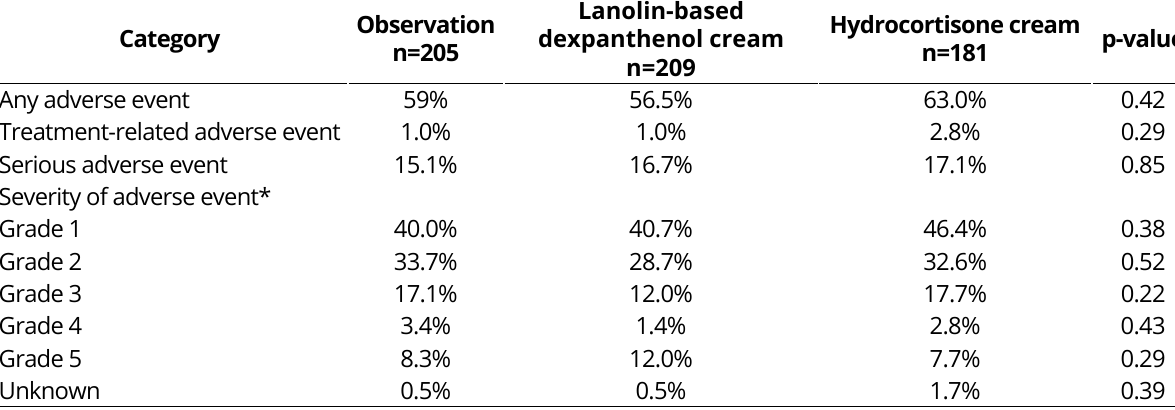
Table 6. Frequency of adverse events along the